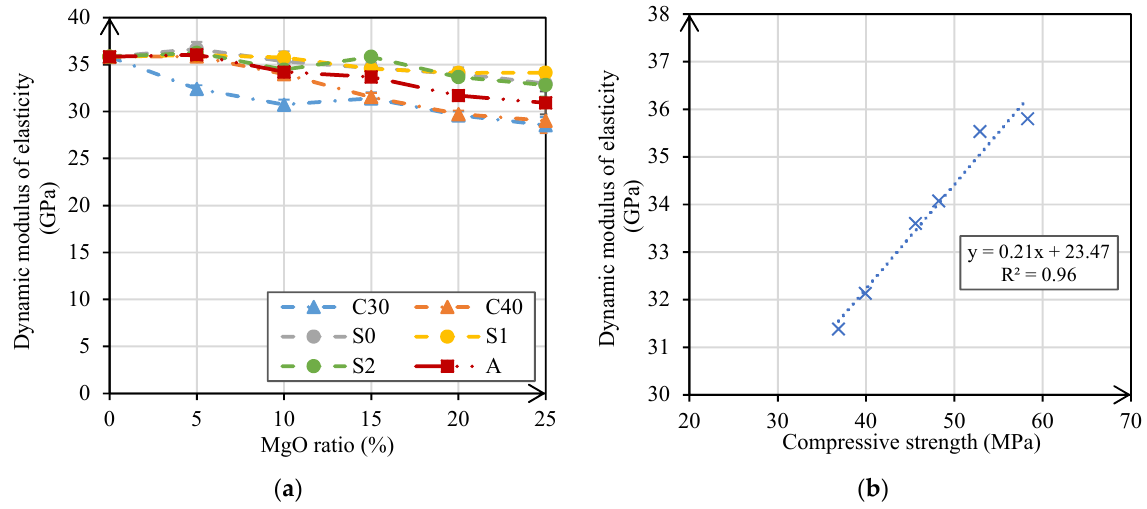
Figure 8. Modulus of elasticity versus MgO content ( a ); compressive strength versus modulus of elasticity ( b ).